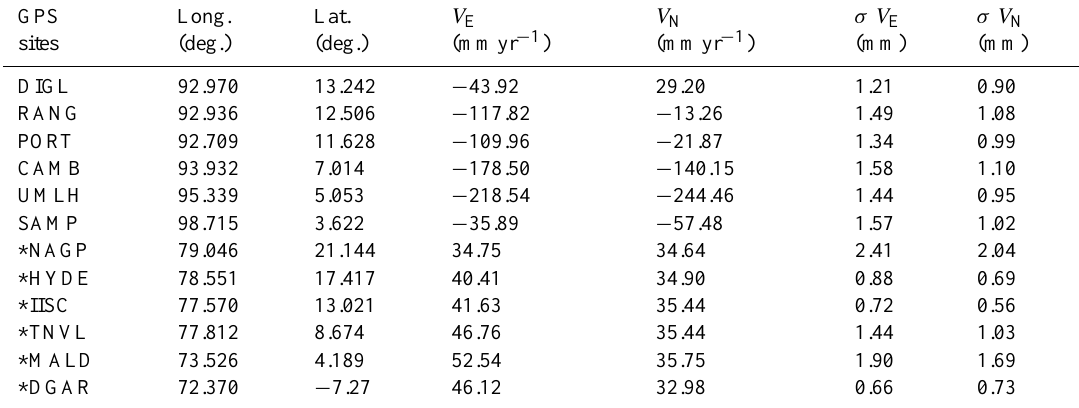
Table 1. Postseismic velocity (ITRF2005) in all the three components: east ( V E ) and north ( V N ) for the postseismic transients shown in Fig. 2. The additional six sites on the Indian plate (marked by *) are used for constraining the GPS stations shown in Fig. 2. GPS Long. sites (deg.)